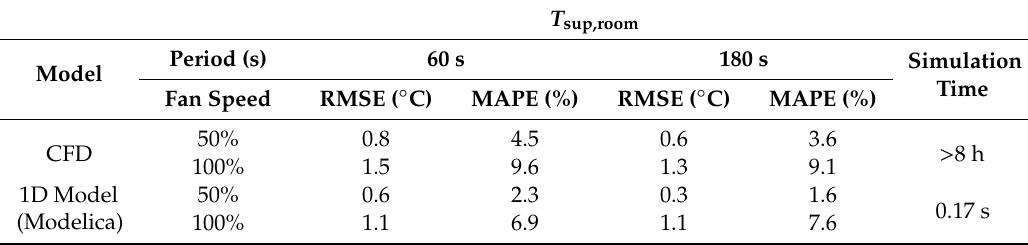
Table 8. Performance indicators regarding the supply temperature for both simulation models.